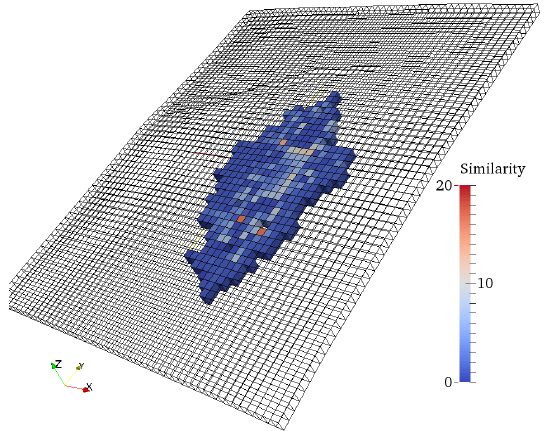
Figure 10. Spatial distribution of the self-similarity for the hetero- geneous